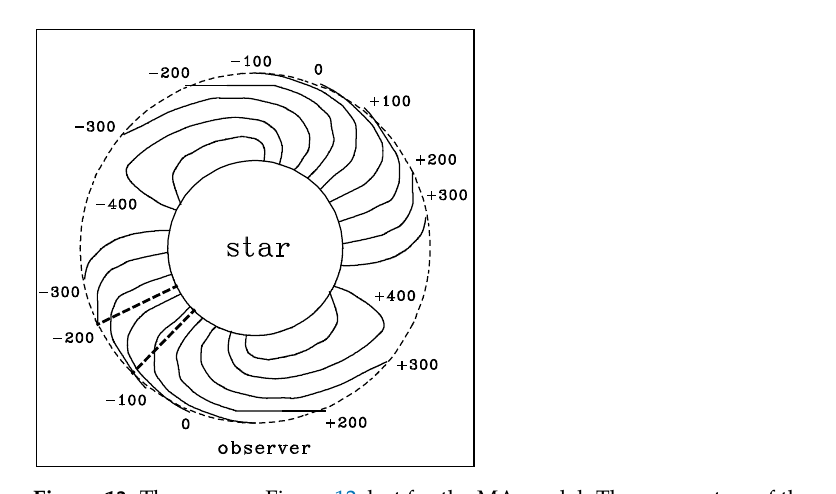
Figure 12. Picture of the SERVs distribution in the disk plane near the star. The case ( a ) is for the Keplerian disk; the case ( b ) is the same as ( a ) but with a radial velocity of the accretion onto the star of V = 100km/s. The corresponding values of the radial velocities are indicated near each SERV in the framework of the observer.